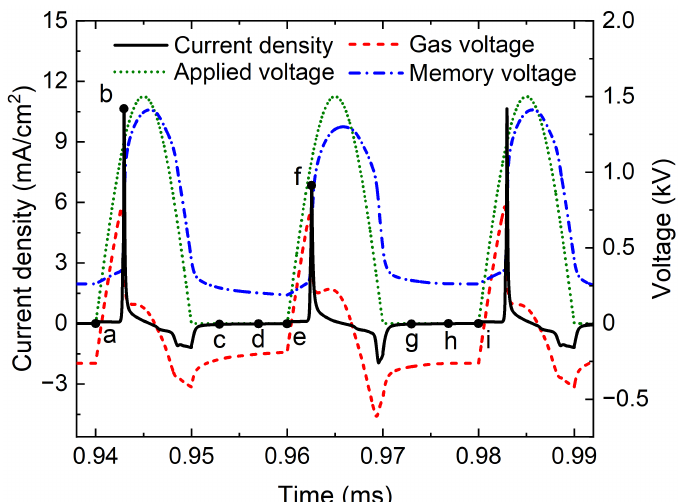
Figure 6. Temporal evolutions of current density, applied voltage, gas voltage, and memory voltage in P2 discharge with a gap width of 4.2 mm.